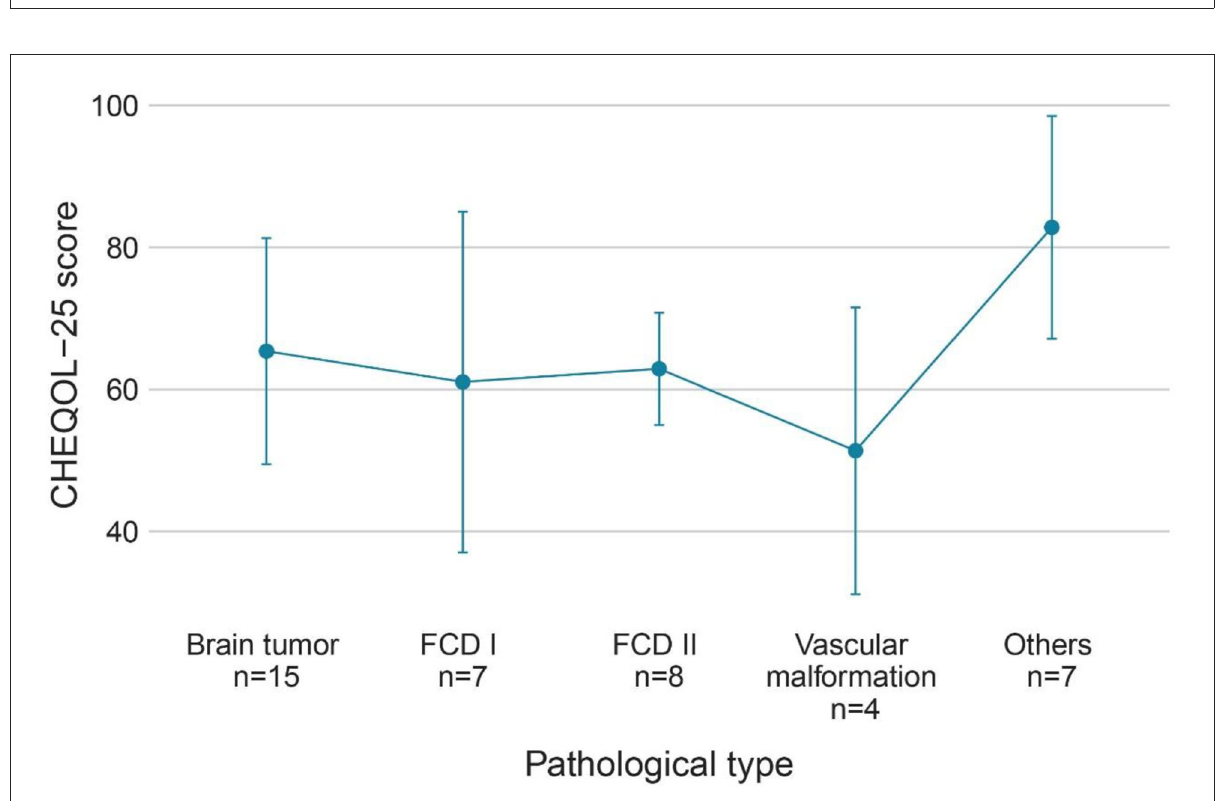
FIGURE4 QoL (CHEQOL-25 total score) group means ( ± standard error) of patients with different pathologic types. QOL, quality of